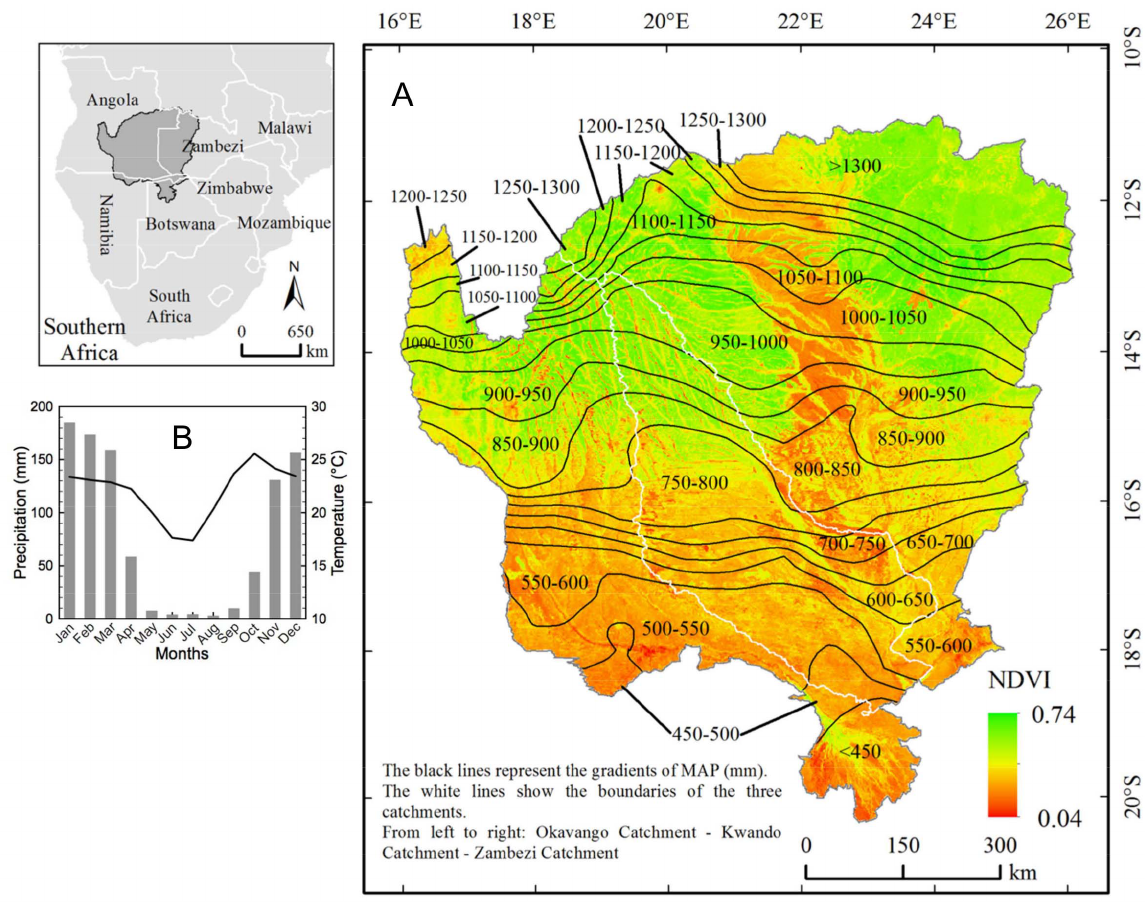
Figure 1. Geography of the study area with (A) mean annual NDVI and precipitation and (B) climograph. Spatial pattern of mean annual NDVI across the study area, derived from monthly MODIS NDVI data from 2001 to 2010. The subset polygons correspond to mean annual precipitation intervals. The inset map shows the geographic location of the study area in southern Africa.